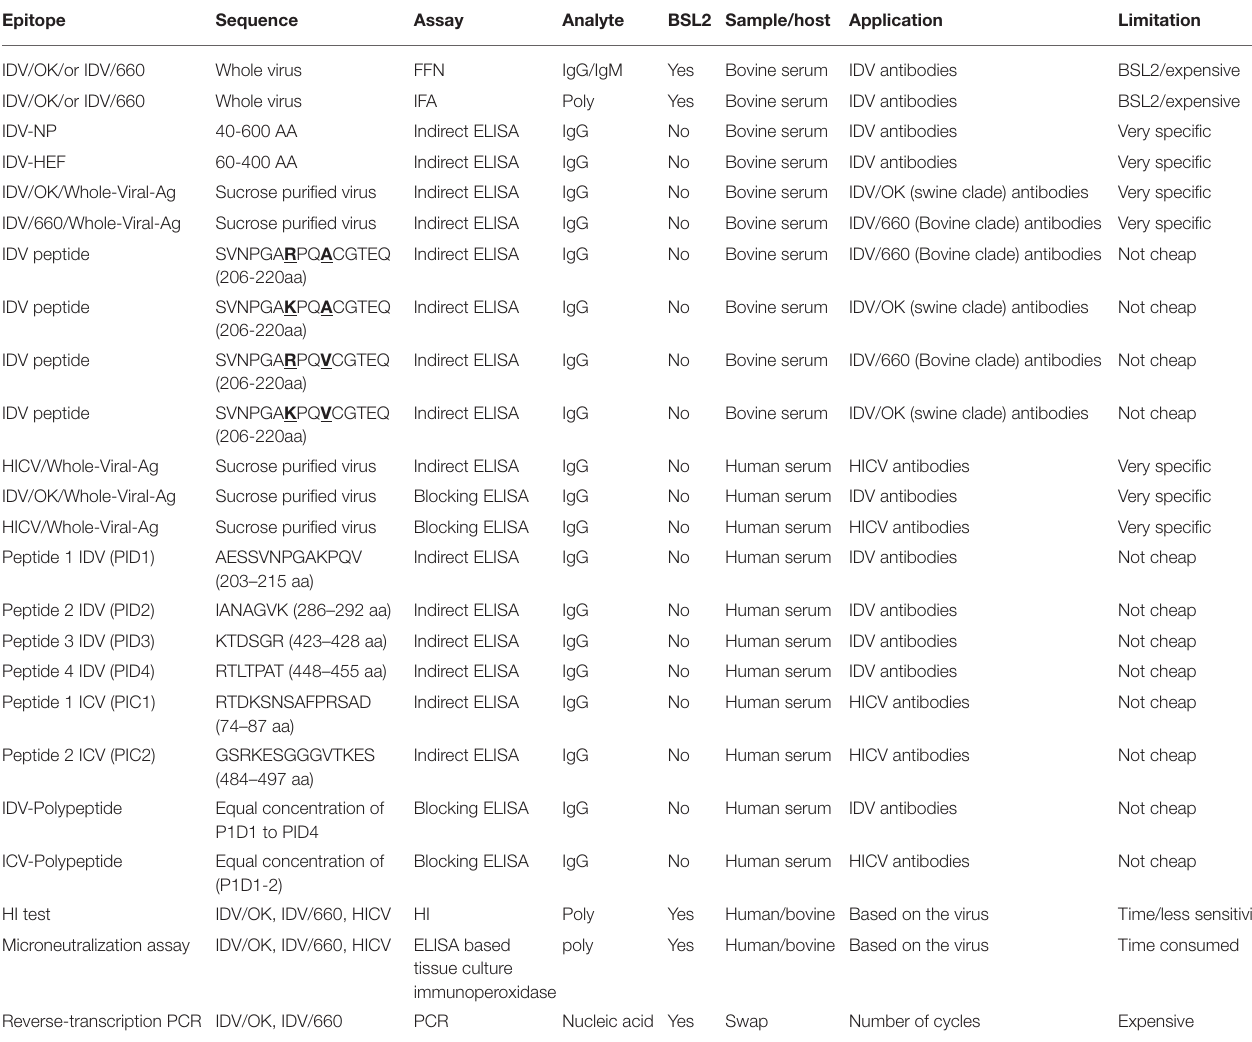
TABLE 2 | Summary for the representative assays in this study compared to the shaded standard assay used for influenza viruses.